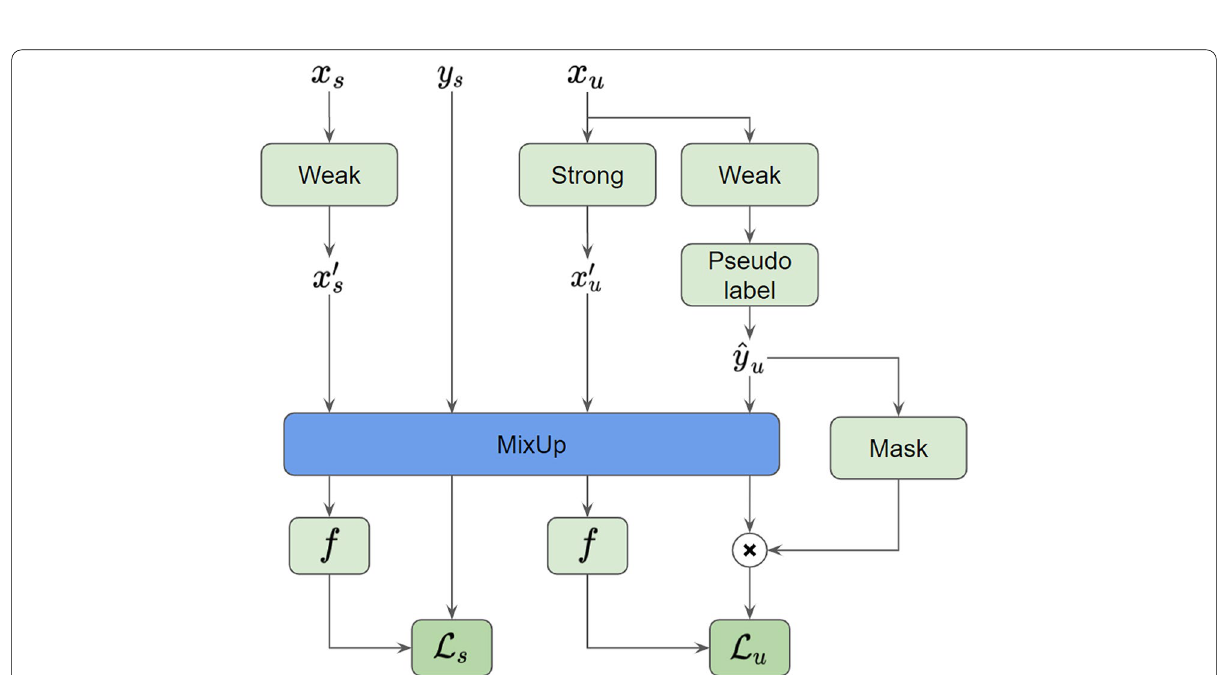
Fig. 5 FixMatch workflow. A weakly augmented version of x u is used to compute a pseudo-label ˆ y u and a mask. The strongly augmented variant is used to compute the unlabeled loss term. The mixup component is used on a concatenated set of labeled and unlabeled samples (FixMatch +